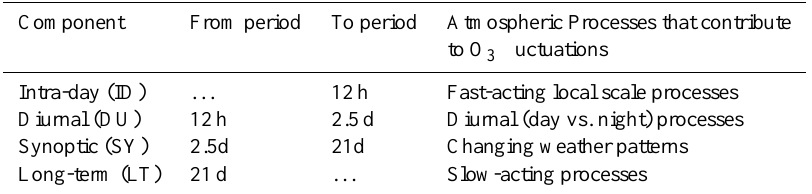
to O 3 fluctuations Fast-acting local scale processes Diurnal (day vs. night) processes Changing weather patterns